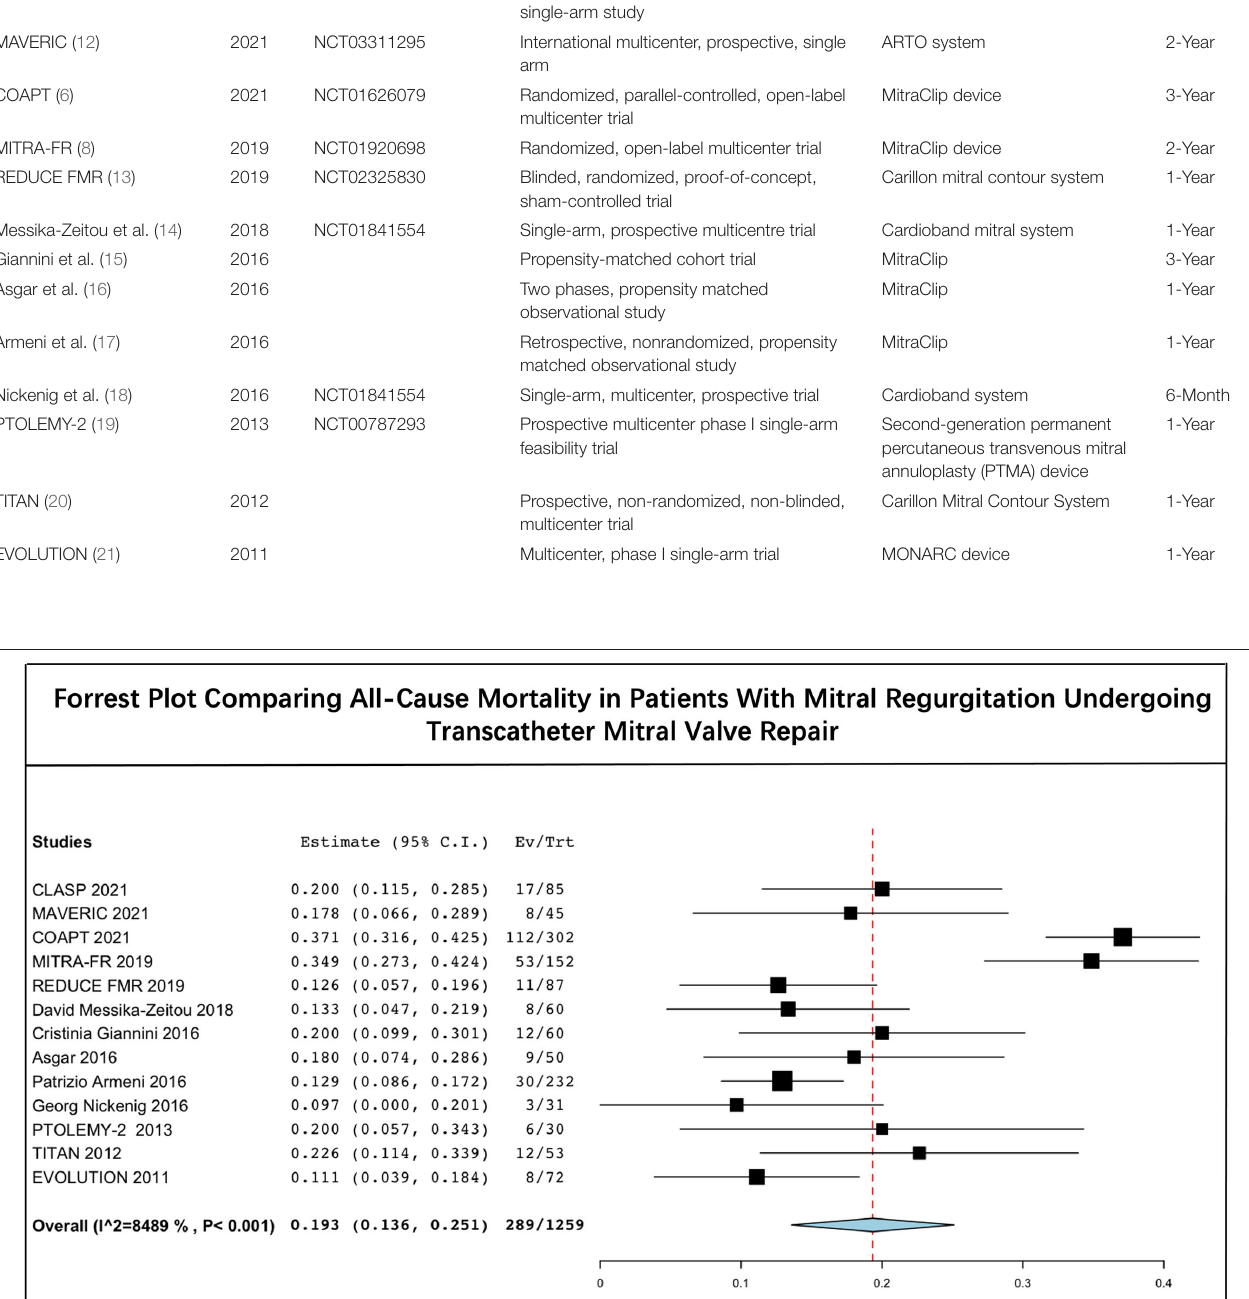
Frontiers in Cardiovascular Medicine |